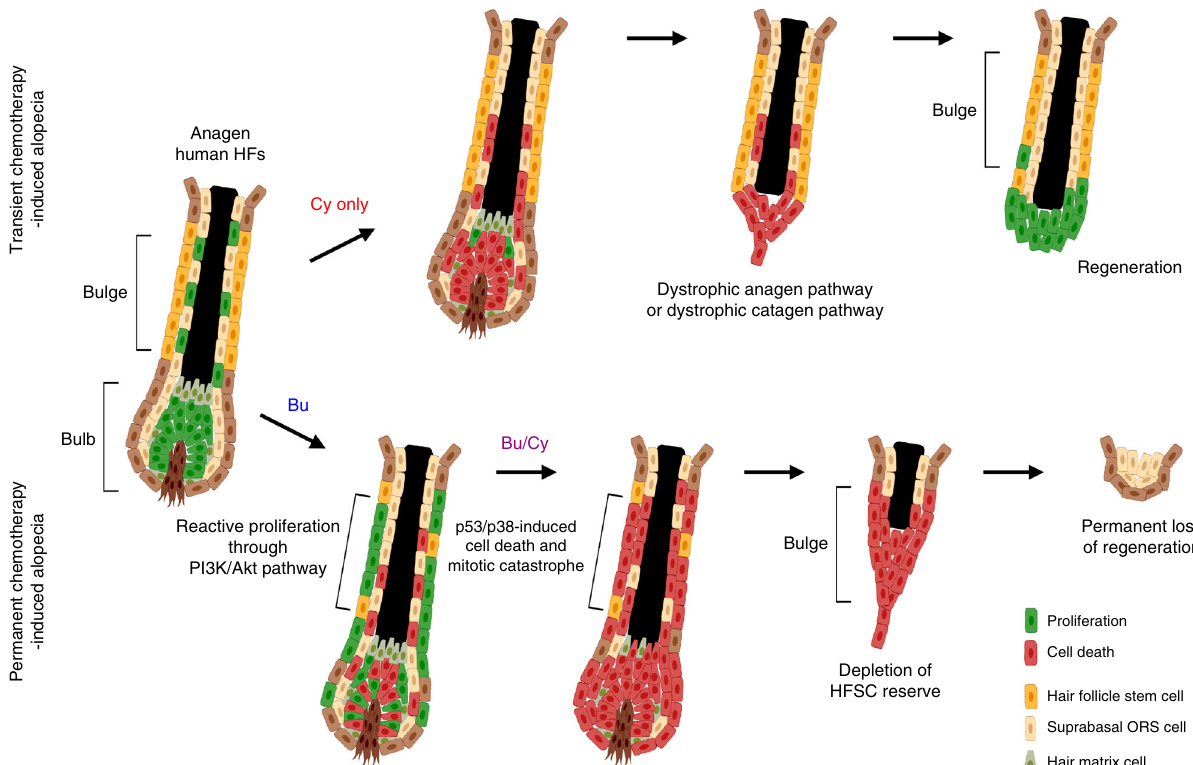
Fig. 9 Mechanism of the permanent loss of regeneration. In transient loss condition, human HFs recover their regenerative segment based on intact HFSCs in the permanent segment through dystrophic anagen pathway or dystrophic catagen pathway 13,45 . However, in permanent loss condition, priming mobilization of HFSCs by initial Bu treatment makes quiescent HFSCs vulnerable to DNA damage-induced cell death by subsequent Cy treatment, resulting in loss of the stem cell reserve for regeneration. Bu busulfan, Cy cyclophosphamide, Bu/Cy busulfan followed by cyclophosphamide, HFSC hair follicle stem cell, ORS outer root